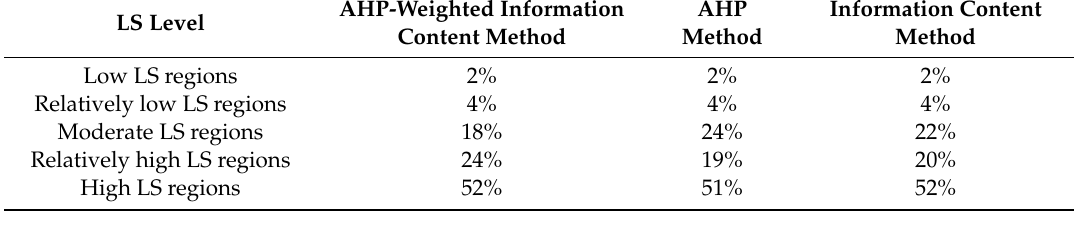
17 of 23 Figure 6. Validation of LS assessment of 212 randomly selected landslide sites for the validation models. ( a ) AHP-weighted information content method, ( b ) AHP method, ( c ) information content method. A comparison of the LS assessment results and the distribution of random landslide sites in the study area shows that all of the LS assessment results correspond well to the distribution of landslide